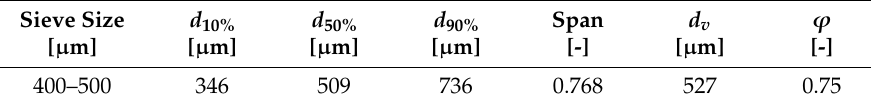
Figure 4. XRD diffraction at small angles for the as-made silica.